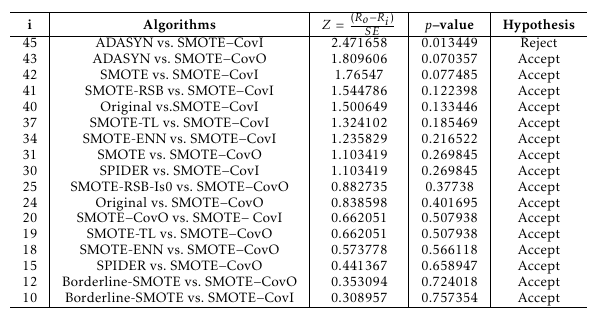
Table 5. Nemenyi’s test with P-values α = 0 .